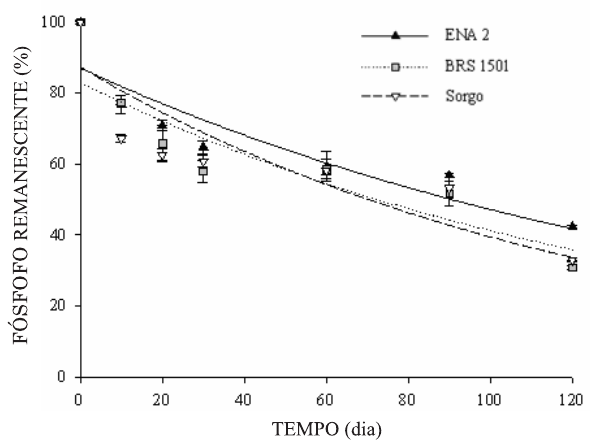
Figura 3. Teores de fósforo na matéria seca remanescente das plantas de cobertura em avaliações realizadas ao longo do tempo em bolsas de decomposição na superfície do solo. (A equação e a significância dos ajustes estão apresentadas no Quadro